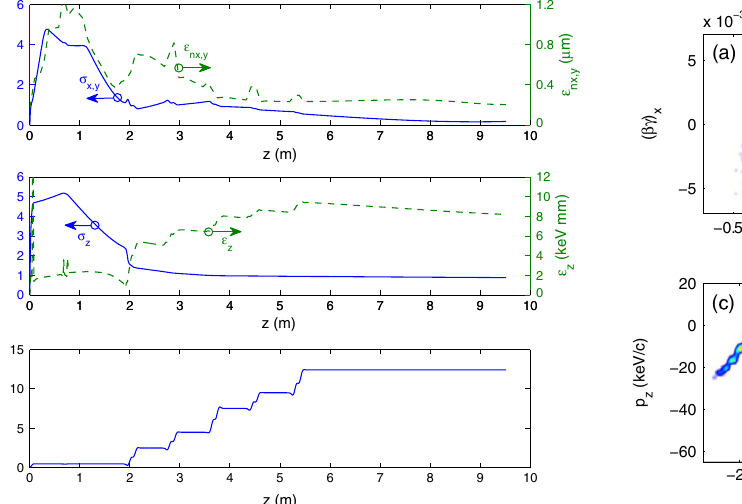
FIG. 10. Beam envelopes for 80 pC ( MTE ¼ 120 meV ) in the dc gun photoinjector. The initial laser pulse is 10 ps rms.